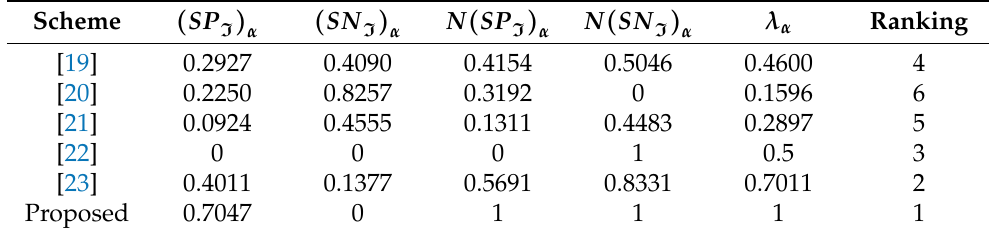
Table 11. Analysis results of five state-of-the-art schemes.